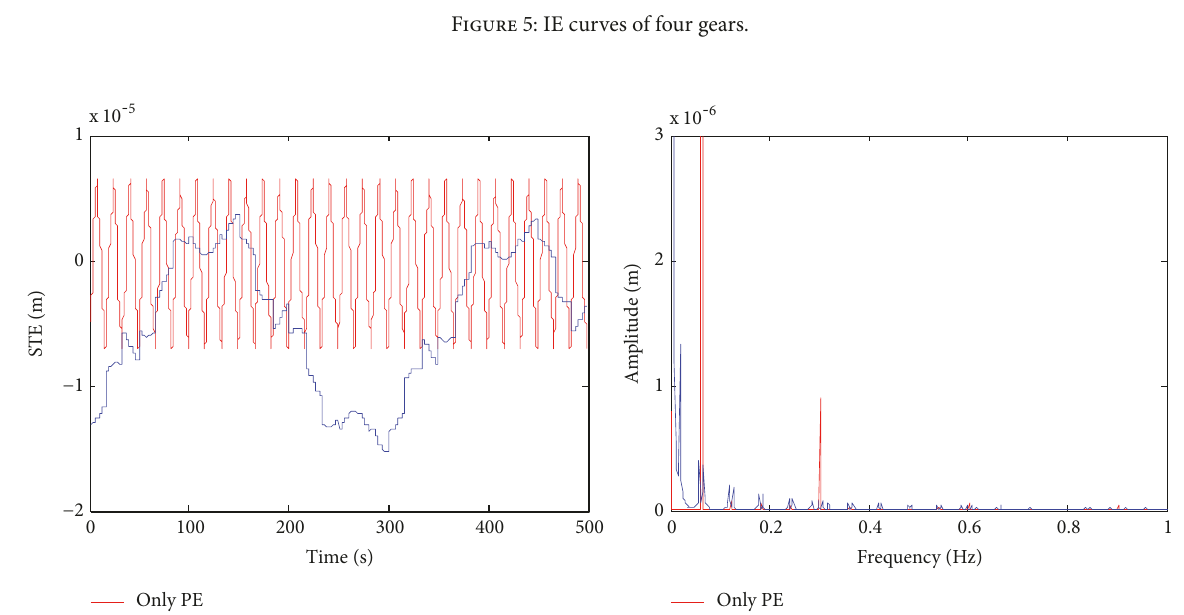
Figure 6: Effects of PE and IE on overall transmission error of gear